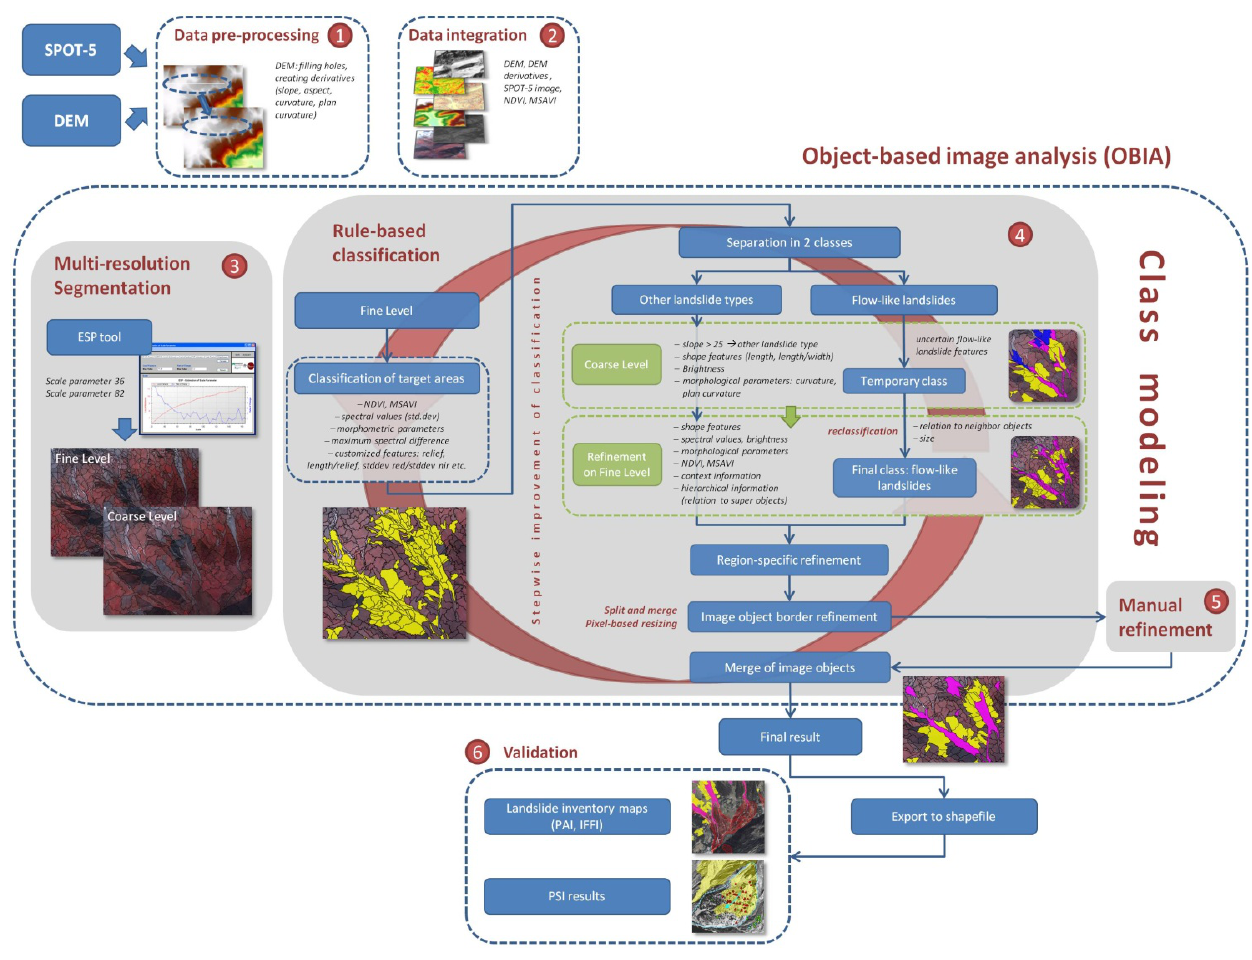
Figure 5. Workflow for the semi-automated detection of flow-like landslides and other landslide types in an object-based